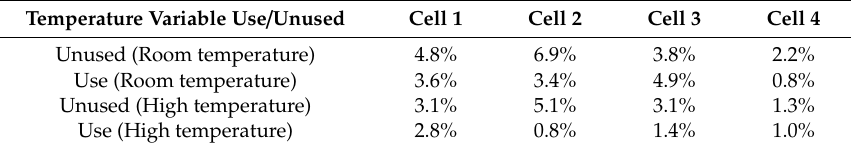
Table 4. Comparison of the SOC estimation results using the MNN of Cell 1 to Cell 4 according to the temperature